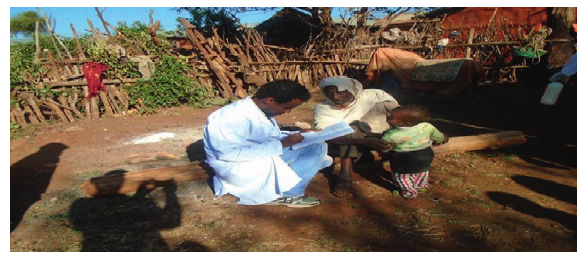
Figure 7: Picture taken during questionnaire survey in the study